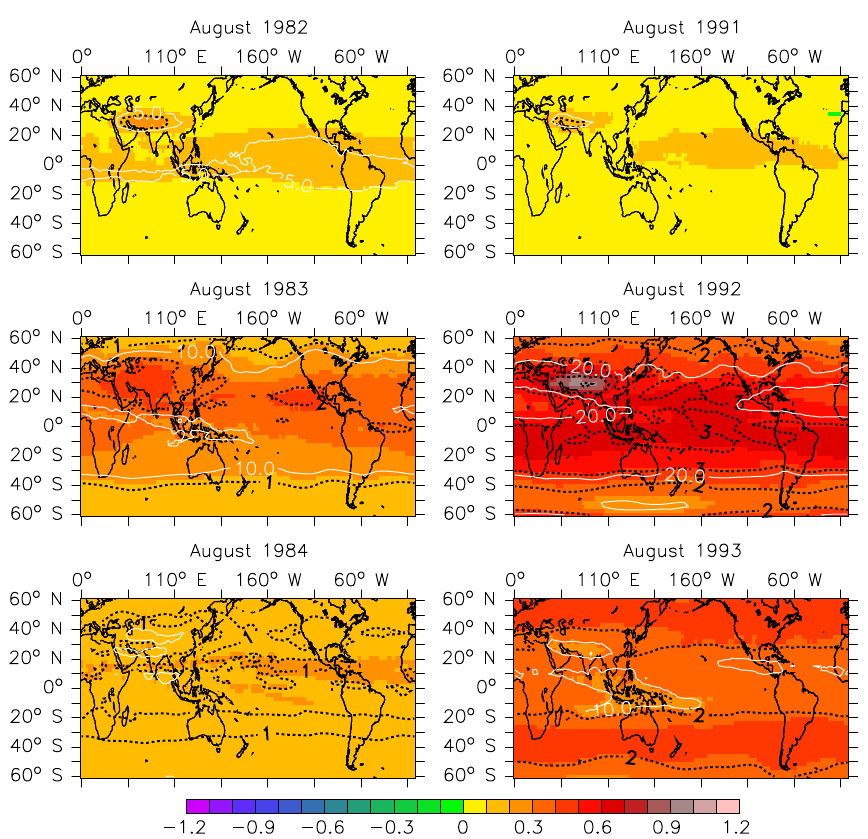
Figure 11. SWV (ppmv, colours) as absolute differences (VOL-NOVOL) as a near global (60 ◦ S–60 ◦ N) horizontal cross section at 75hPa for the month of August in the year of the eruptions and in the following 2 years. White contours indicate the relative increase in SWV (intervals 5, 10, 20, and 50%) compared to the background value of NOVOL. Black dashed contours mark significant increases in units of standard deviation for the month of August in NOVOL (calculated over the time period 1979–2013). The left column shows the El Chichón period, the right column the Mount Pinatubo